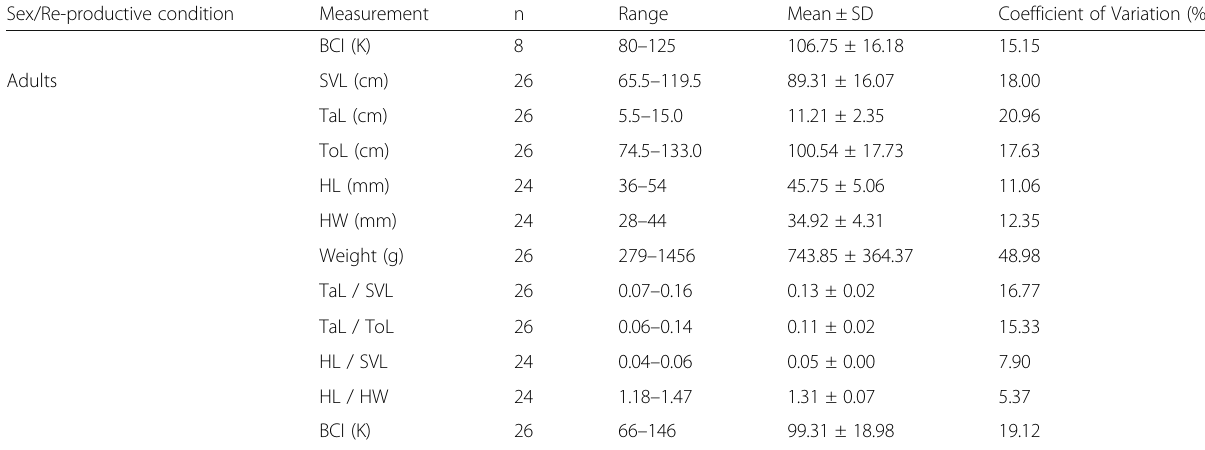
Table 1 Morphometric characteristics of juvenile and adult blunt-nosed vipers from Cyprus (SVL, TaL and ToL rounded to the nearest 0.5 cm) (Continued) Sex/Re-productive condition